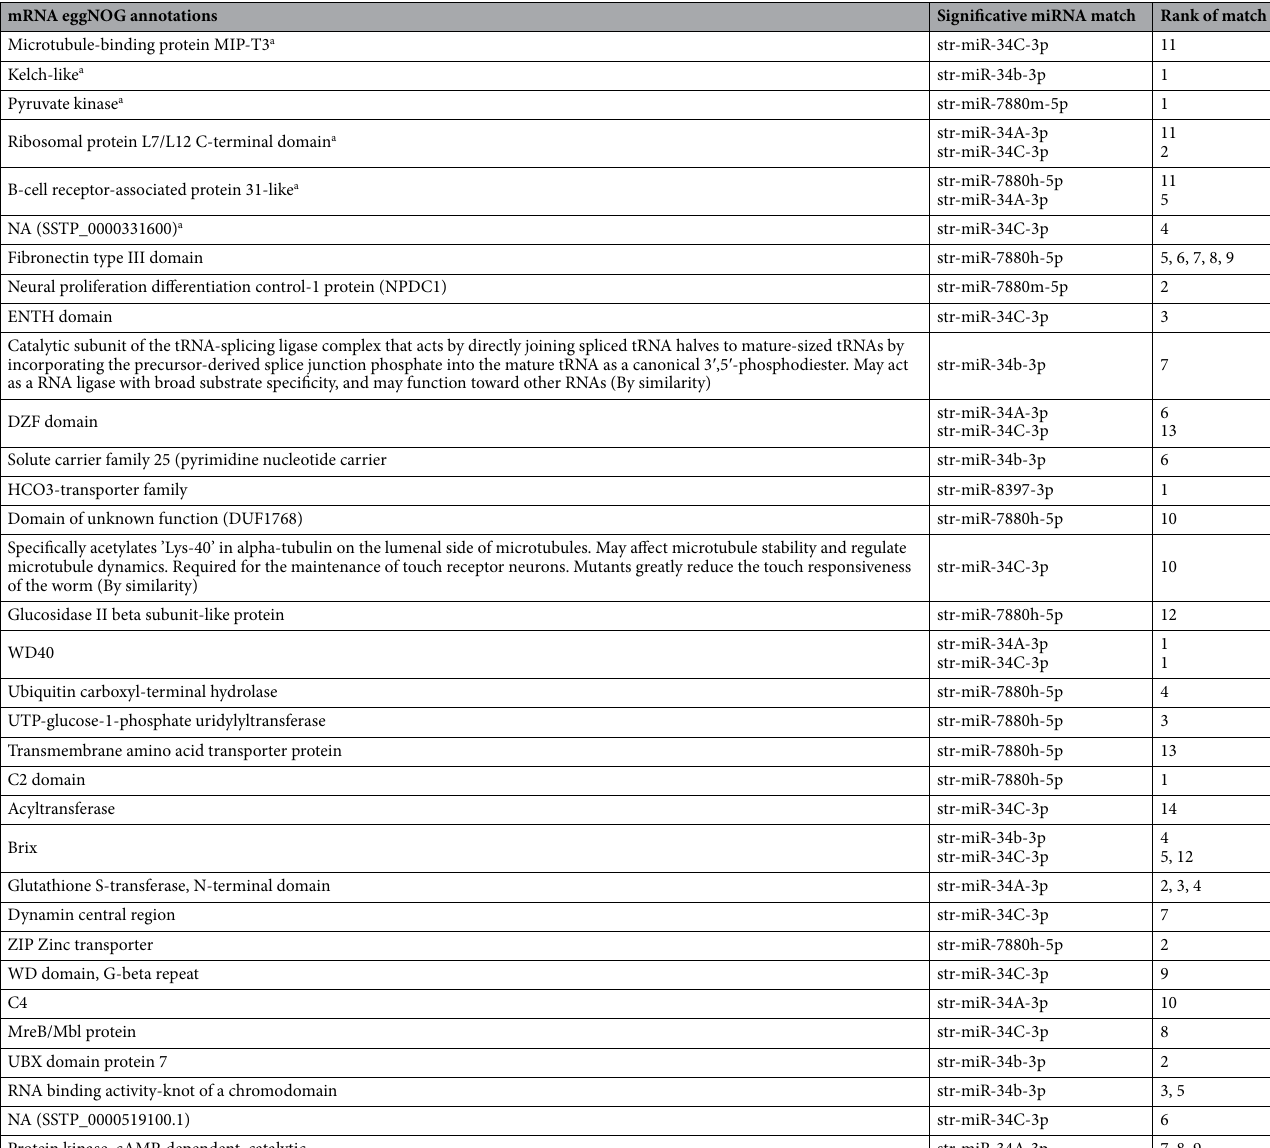
Table 3. List of top significant predicted targeting between mRNAs and miRNAs of S. stercoralis . Rank of match indicates the position of the match in the ranked list of matches (ordered by strength of match) outputted by the software PITA; multiple ranks indicate multiple matching between miRNA and mRNA. a Differentially expressed putative targets at nominal p-value <